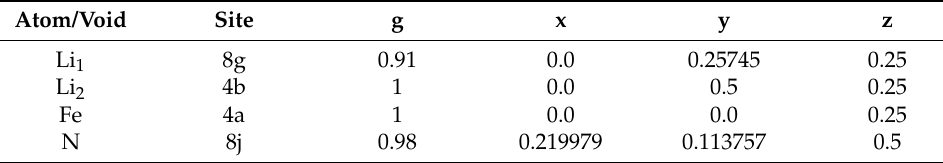
Table 2. Structure characteristics of Li3FeN2.